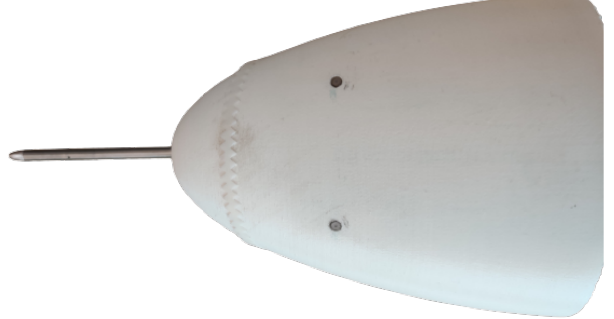
Figure 2. The nose cone of the Cyclone with (from left to right) the Pitot tube, zig-zag tape and the two flush-mounted